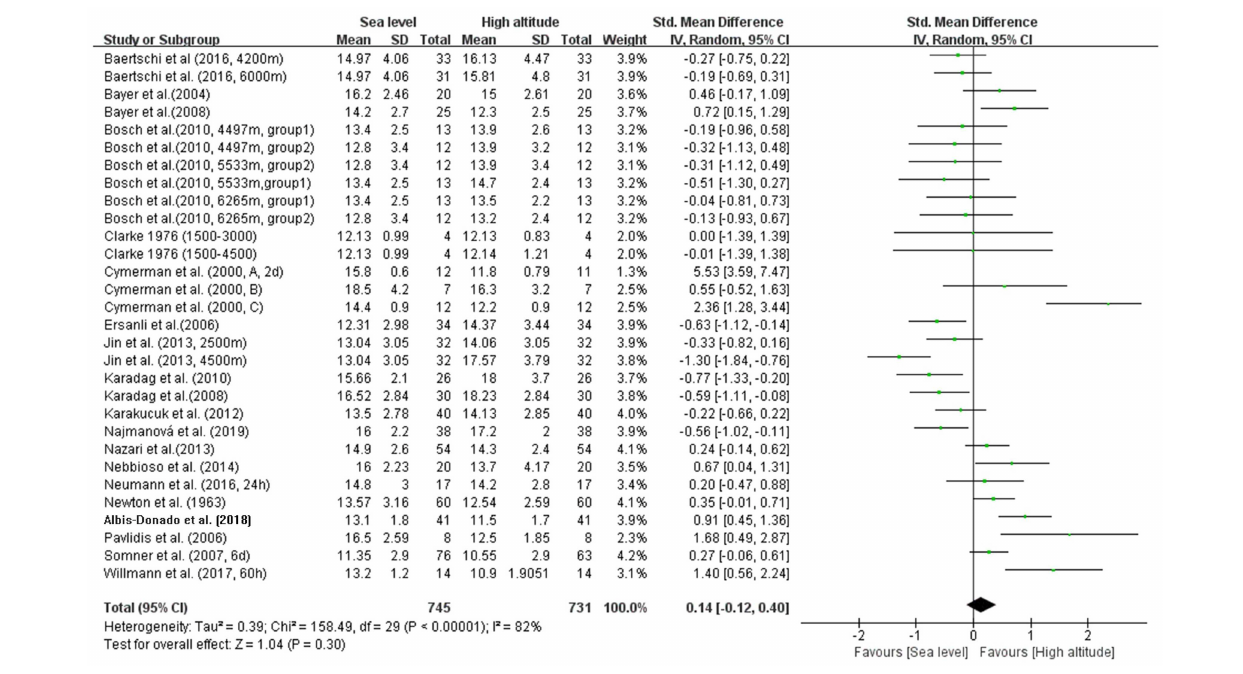
Frontiers in Physiology |